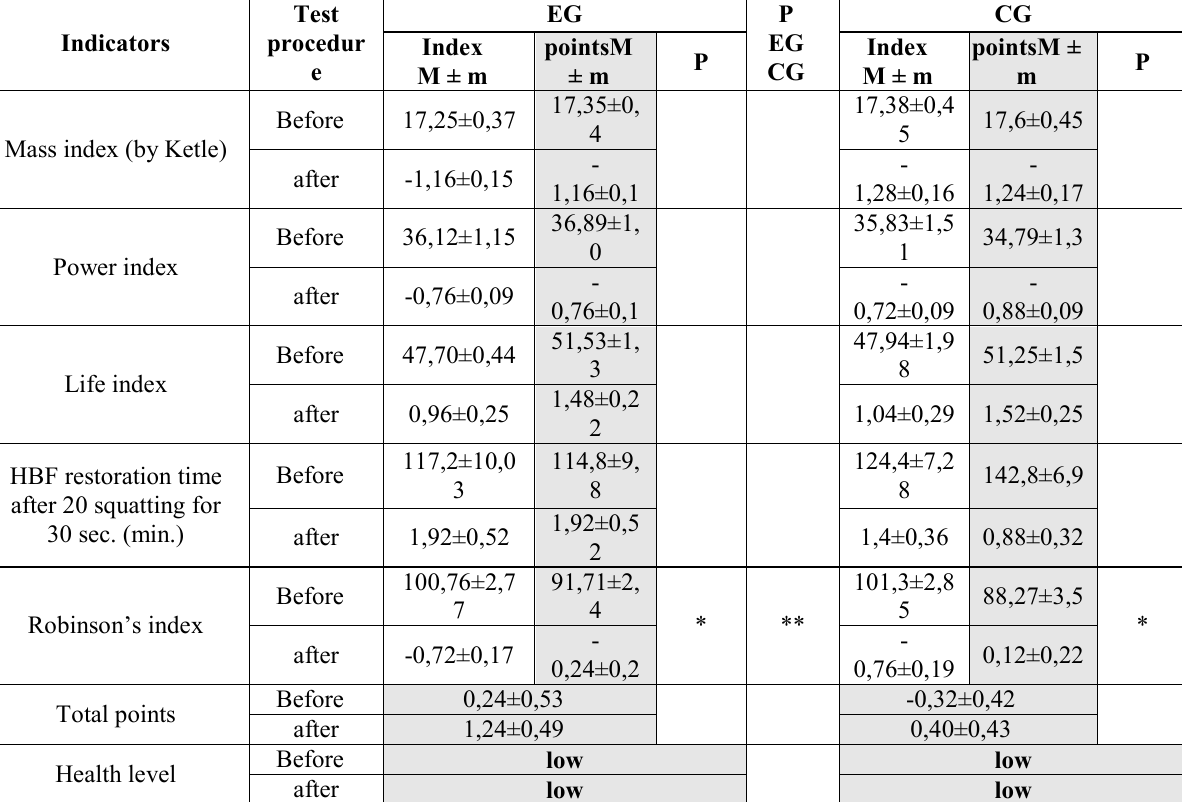
Evaluation of EG (n=25) and CG(n=25) girls somatic health before and after the second pedagogical experiment